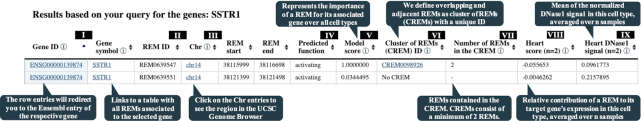
First two rows of an example result table of EpiRegio’s Gene query for SSTR1.